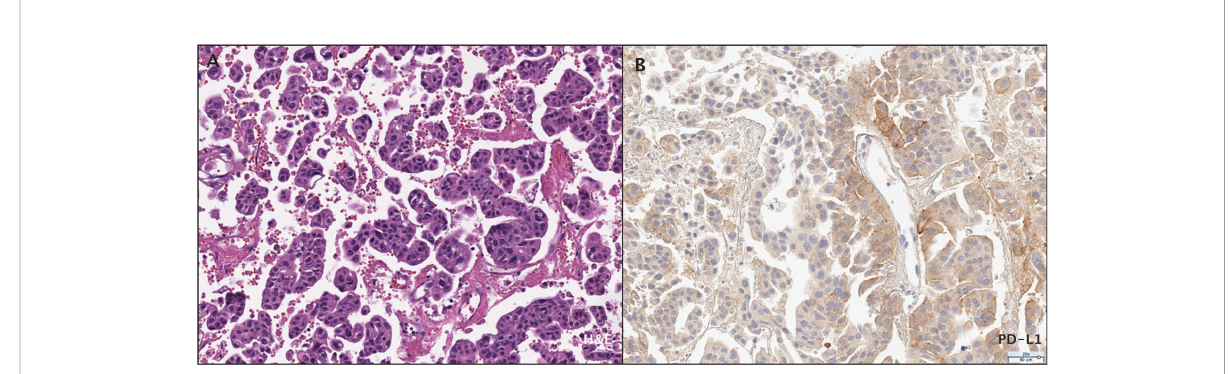
FIGURE 2 Histopathological assessment of the patient's bladder urothelial carcinoma. (A) Micropapillary histopathology was observed by H&E staining. (B) PD-L1 expression was assessed by immunohistochemistry.